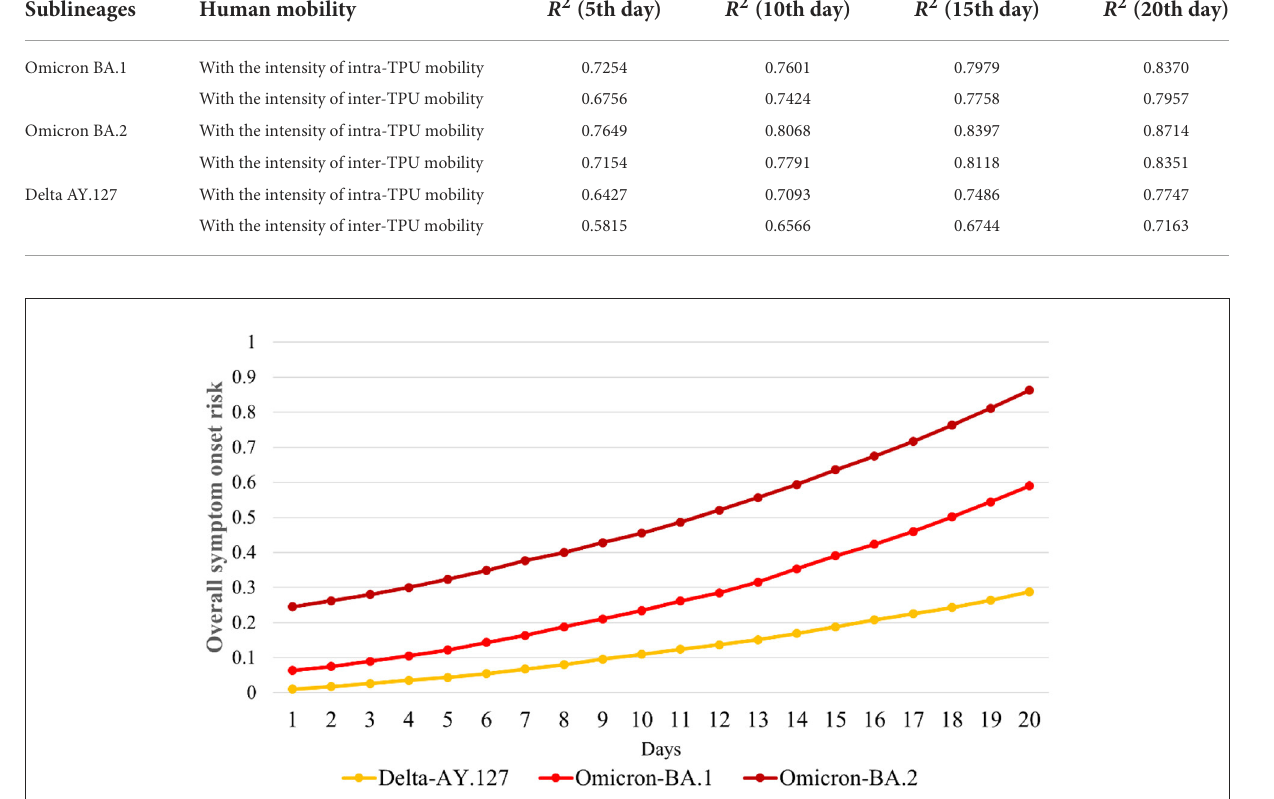
FIGURE6 Daily overall risk of COVID-19 symptom onset in Hong Kong within 20 days after Omicron BA.1, BA.2, and Delta AY.127.